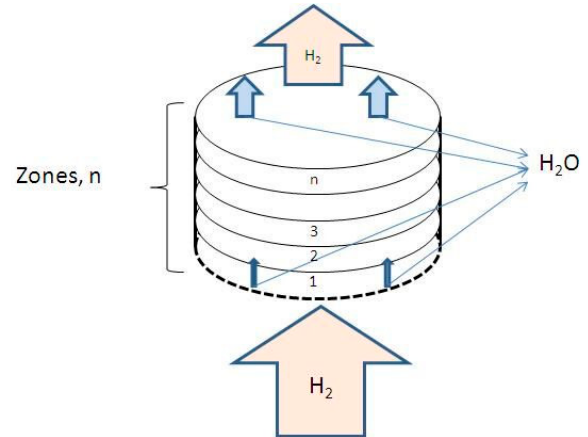
Figure 12. Schematic representation of fluidized powder bed [3].